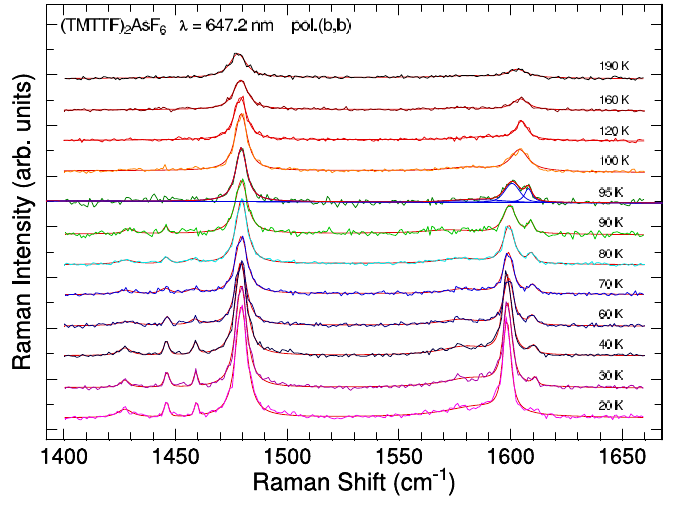
with λ = 647 . 2 nm for the polarization ( b (cid:48) , b (cid:48) ). Most obvious is the splitting of the ν mode around 1600 cm − 1 and the evolution of three features between 1425 and 1460 cm − 1 as = 102 K. For T = 95 K the two Lorentzian contributions the temperatures drops below T CO are plotted separately to demonstrate the